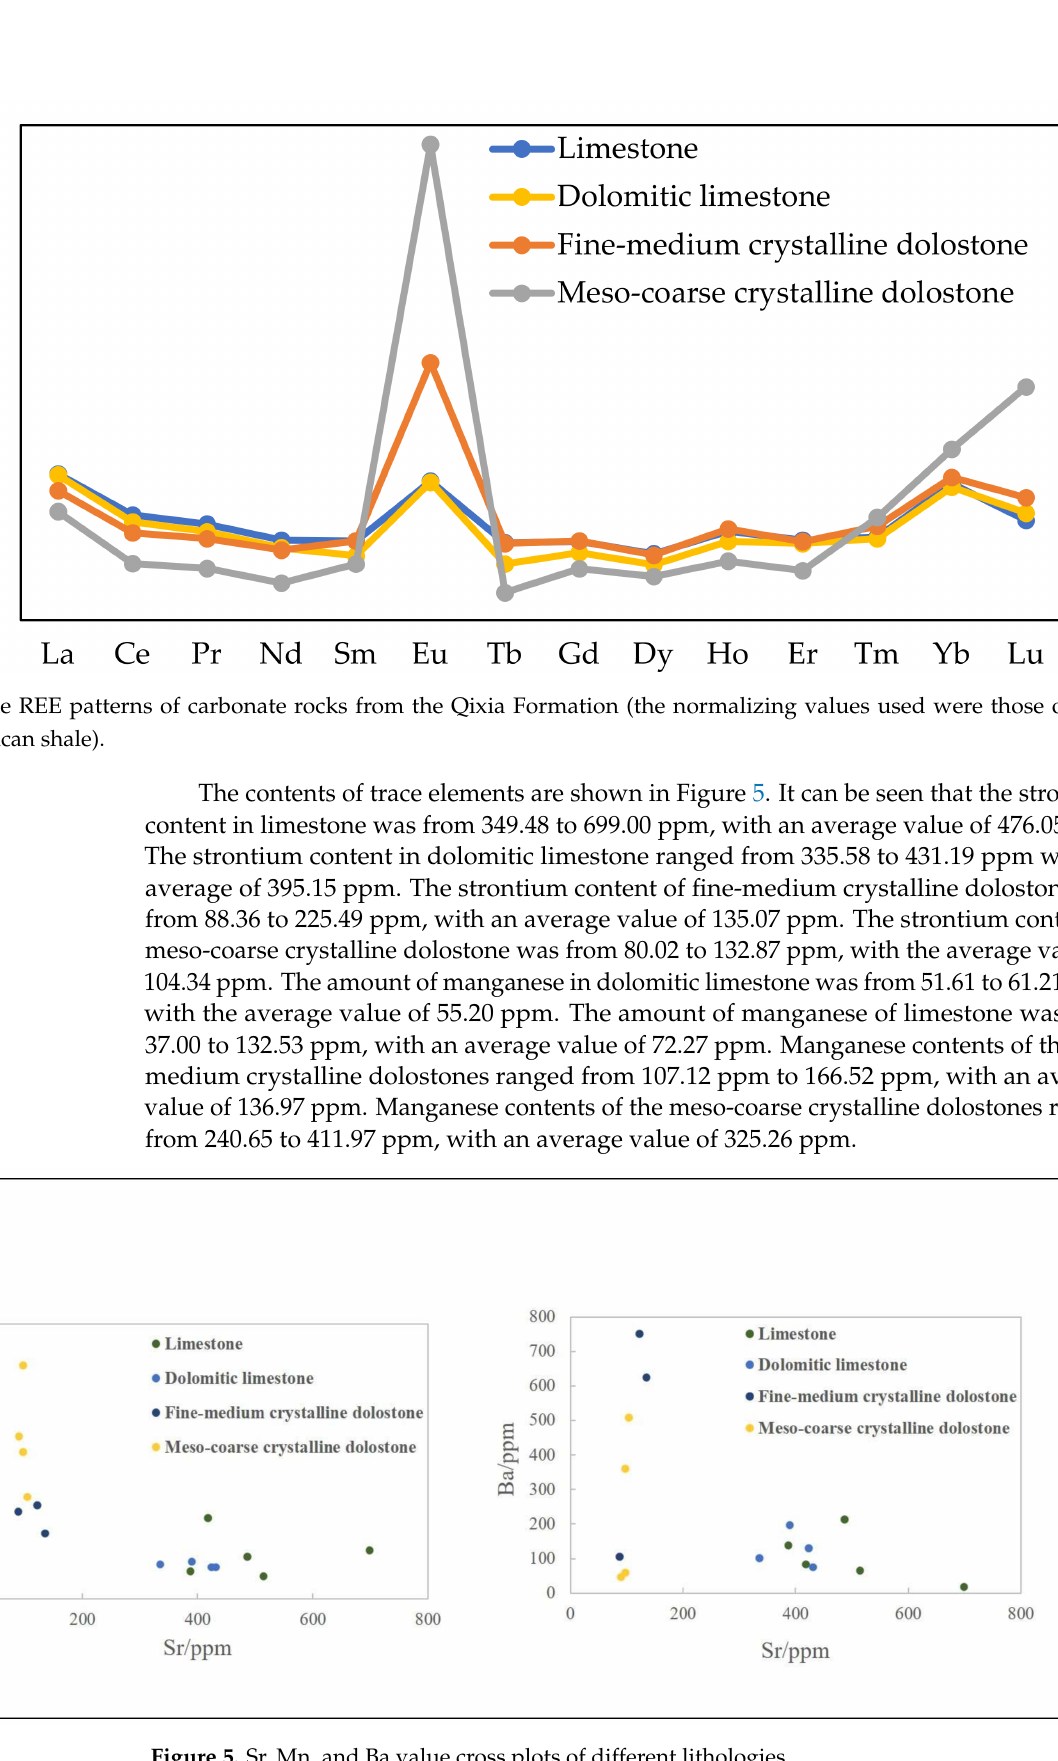
Figure 5. Sr, Mn, and Ba value cross plots of different